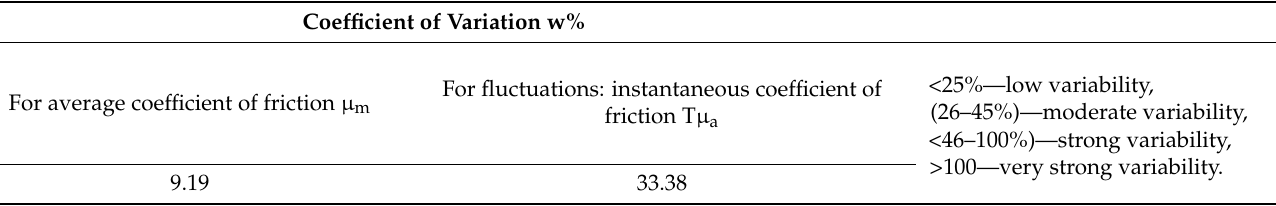
Table 5. Values of the coefficients of variation for µ m and T µ a